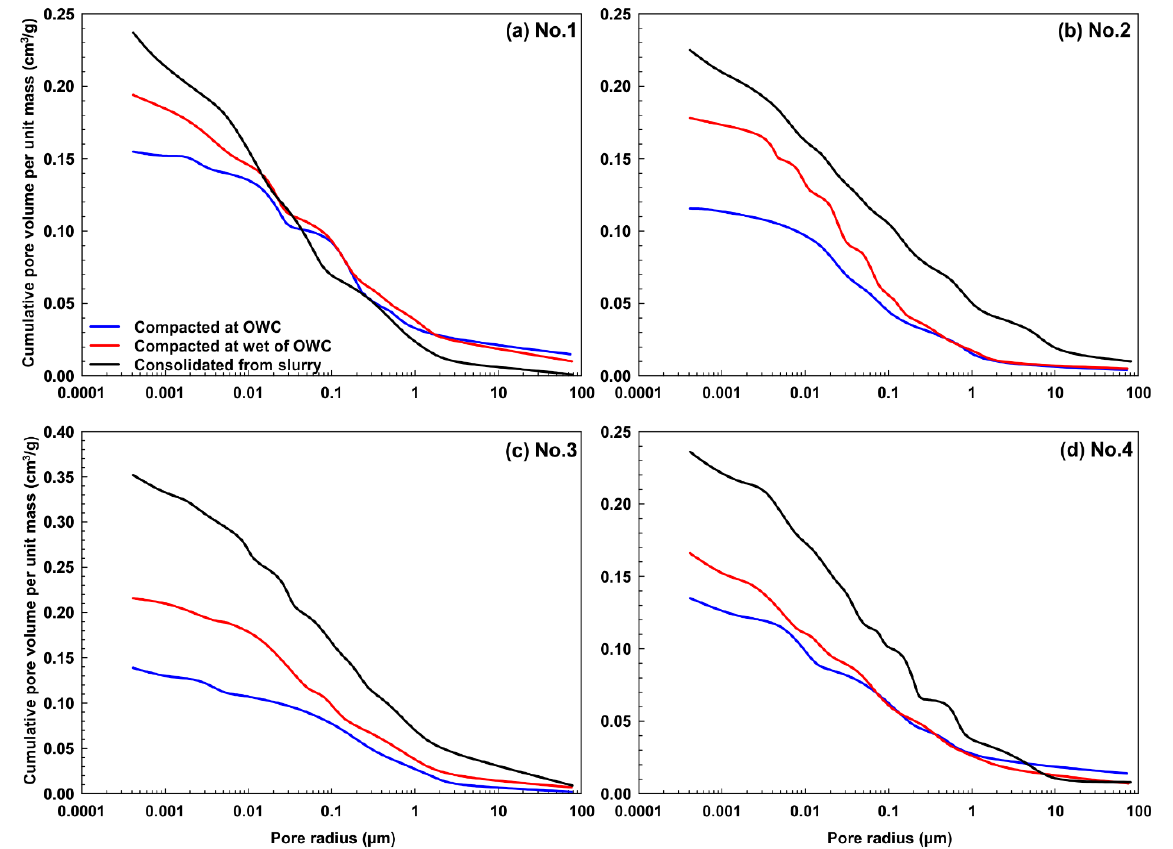
Figure 13. Cumulative pore volume-pore radius relationship of clayey samples: ( a ) No. 1, ( b ) No. 2, ( c ) No. 3, and ( d ) No. 4.